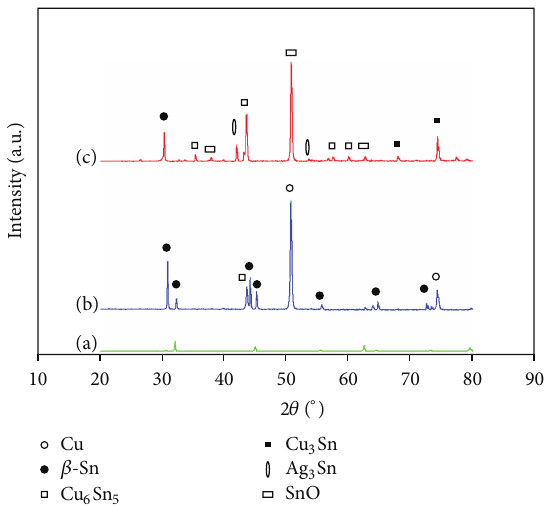
Figure 4: XRD patterns from the top surface of (a) SAC305 solder wire, (b) as-deposited SAC305 thin film, and (c) as-reflowed SAC305/Cu.